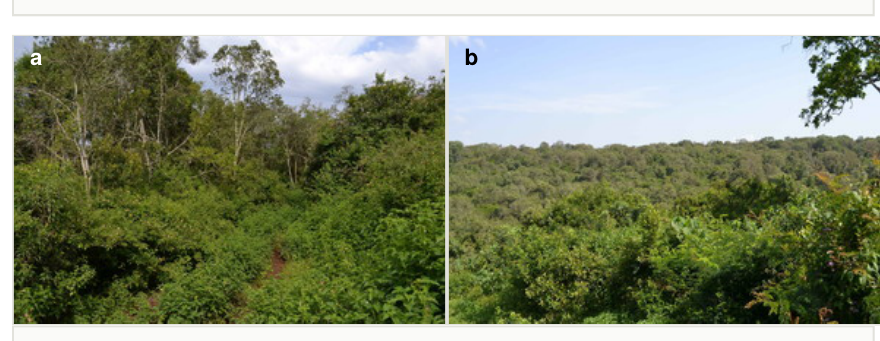
The location of the DeKUWC in central Kenya is shown (a). A map of the DeKUWC with locations of the point counts and acoustic recorders indicated (b).